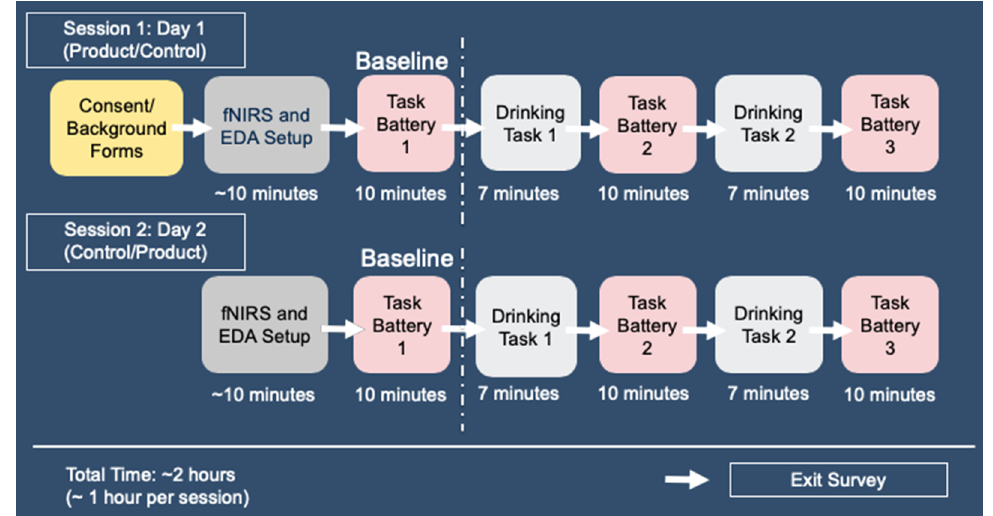
Figure 1. Diagrammatic Representation of the Protocol.